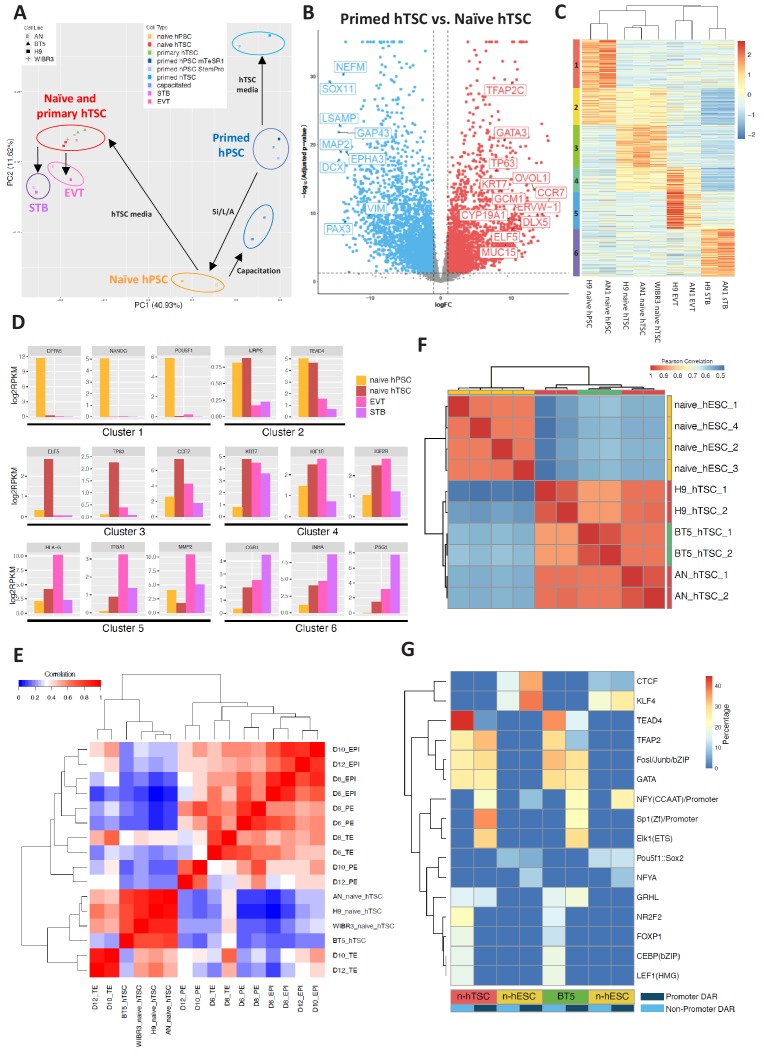
Transcriptomic and chromatin accessibility profiling of naïve hPSC-derived hTSCs.(A) Principal component analysis (PCA) of primed, capacitated, and naïve hPSCs, BT5 hTSCs, naïve hTSCs, EVTs, STBs, and primed hPSCs cultured in hTSC medium based on RNA-seq data. Circles were drawn around samples cultured in the same media. (B) Volcano plots showing fold change (X axis) between naïve hTSCs and primed hPSCs cultured in hTSC medium. The light blue dots represent genes that are the most significantly upregulated in primed hTSCs (defined as those that have a log fold change < −1 and wherein p<0.05). The red dots represent genes that are the most significantly upregulated in naïve hPSCs cultured in hTSC medium (defined as those that have a log fold change >1 and wherein p<0.05). (C) Heatmap of RNA-seq data from naïve hPSCs, naïve hTSCs, EVTs, and STBs (DEGs with more than 2X fold change and p-adj < 0.05 are analyzed). Cluster one represents genes highly expressed in naïve hPSCs only. Cluster two represents genes highly expressed in both naïve hPSCs and naïve hTSCs. Cluster three represents genes highly expressed in naïve hTSCs only. Cluster four represents genes highly expressed in both naïve hTSCs and EVTs. Cluster five represents genes highly expressed in EVTs only. Cluster six represents genes highly expressed in STBs only. (D) Expression levels of key marker genes associated with clusters 1–6. (E) Heatmap indicating the correlation among scRNA-seq data from published day 6, day 8, day 10, and day 12 TE, EPI, and PE (Zhou et al., 2019), as well as RNA-seq data from naïve and BT5 hTSCs. Genes specifically expressed in the TE, EPI, or PE lineages were analyzed (Zhou et al., 2019). (F) Heatmap of ATAC-seq data from naïve hESCs and naïve hTSCs (Pearson correlations were calculated based on genome-wise ATAC-seq signal). Naïve hESC ATAC-seq data were retrieved from a published dataset (Pastor et al., 2018). (G) Transcription factor binding motifs enriched in the promoter and non-promoter regions of the DARs specific to naïve hESCs vs. naïve hTSCs and naïve hESCs vs. BT5 hTSCs.